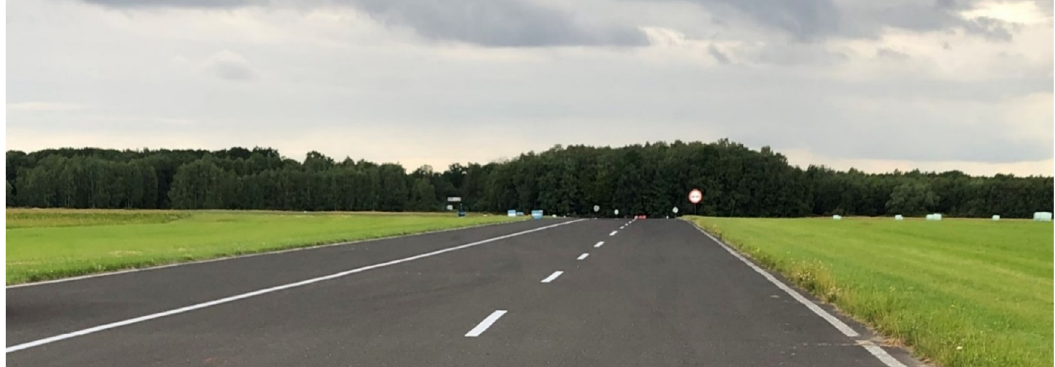
Figure 7: View of the test track. Source: “ authors ” own